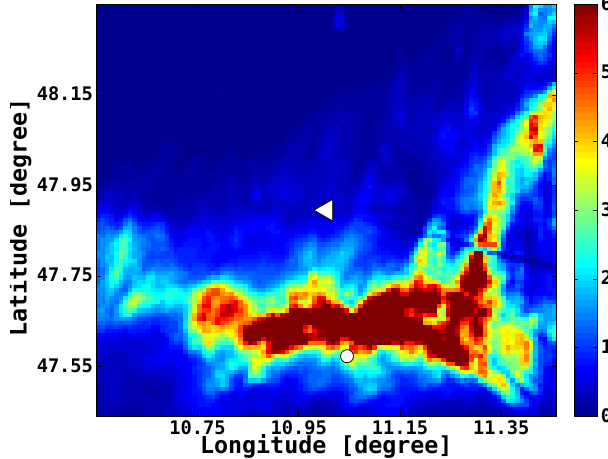
Fig. 2. Precipitation field [mmh − 1 ] derived from radar measure- Fig. 2: Precipitation field [mm/h] derived from radar mea- ments (standard Z / R relationship) at Mount Hohenpeissenberg surements (standard Z/R relationship) at Mount Hohenpeis- on 14 July 2008 (13:00). The position of Hohenpeissenberg senberg on 14/07/2008 (13:00). The position of Hohenpeis- (Garmisch-Partenkirchen) is indicated by a white triangle senberg (Garmisch-Partenkirchen)is indicated by a white tri- angle (circle).